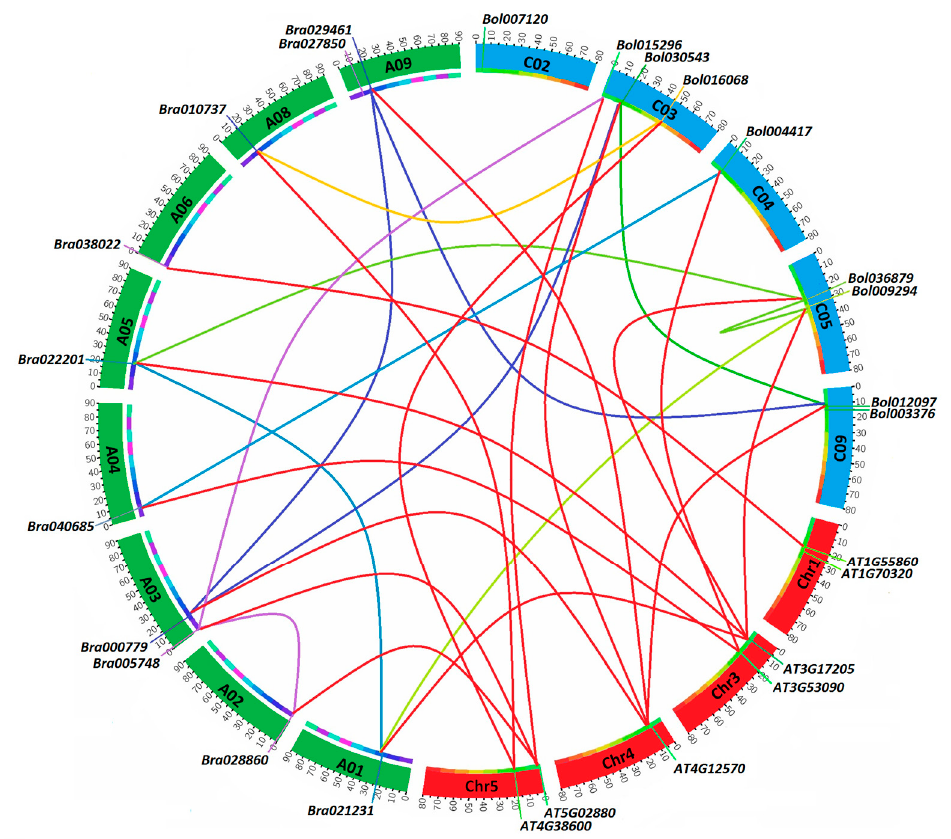
Figure 5. Chromosomal position, synteny, and expansion of HECT genes among B. rapa , B. oleracea , and A. thaliana . Physical locations of each HECT gene are shown across the eight B. rapa , five B. oleracea and four A. thaliana chromosomes. The segmental duplications (within a given species) and syntenic relationships (between two di ff erent species) are represented by di ff erently colored lines. Table 1. Ka, Ks, Ka / Ks ratio and divergence time of the orthologous HECT gene pairs between Arabidopsis and Brassica